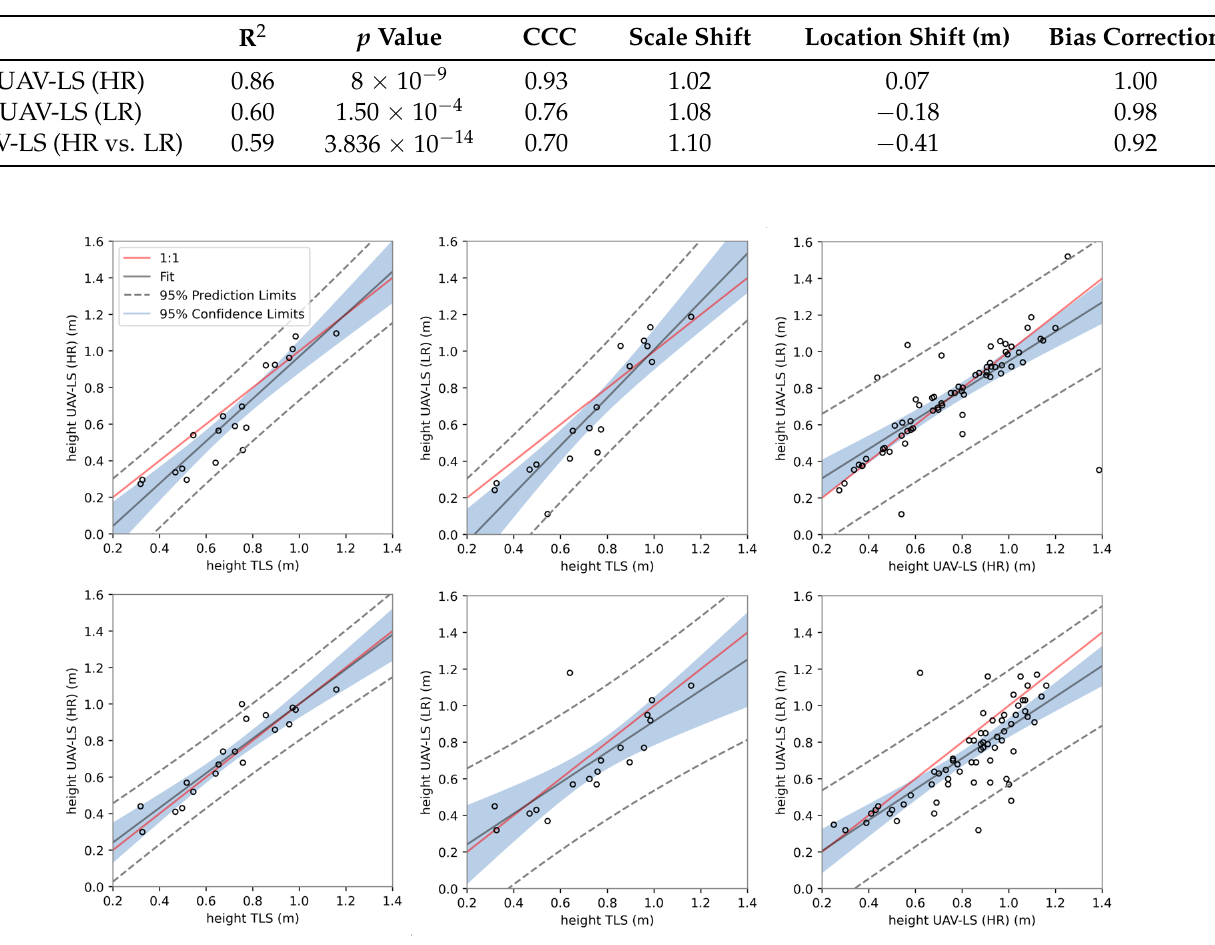
Figure 11. Scatter plot with linear regressions of the height estimations, validated using the benchmark data set. The top three plots show results from the Gaussian approach and the bottom three from the grid